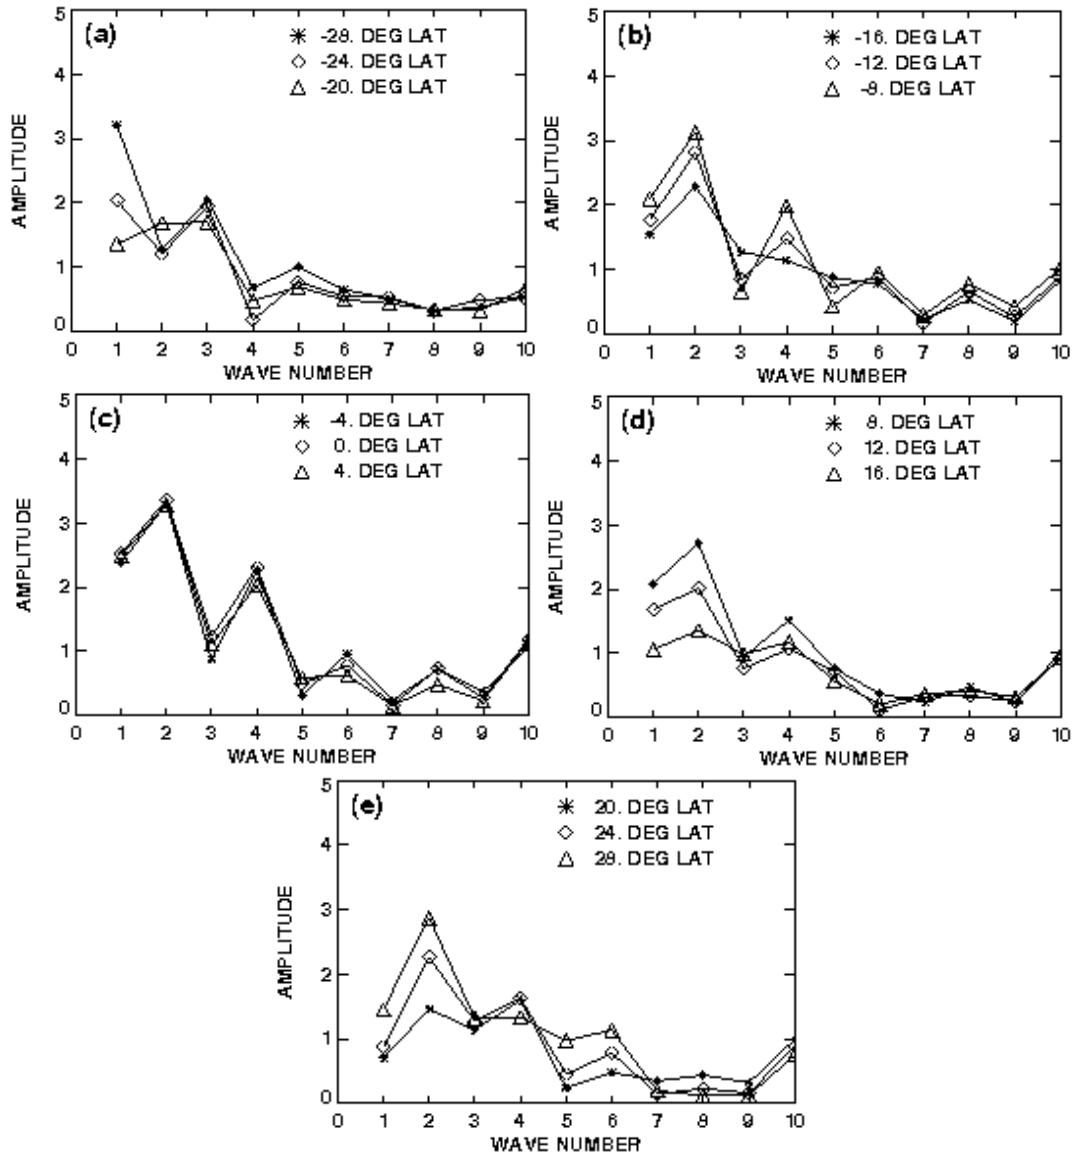
Fig. 3. Estimated Fourier amplitudes ( ◦ K) versus wave number based on zonal mean MLS temperature data at 0.46hPa (about 55km). Wave numbers 3, 4, 5 correspond to periods of 4, 3, 2.4 months, Figure 3. Estimated Fourier amplitudes (ºK) versus wave number based on zonal mean MLS Figure 3. Estimated Fourier amplitudes (ºK) versus wave number based on zonal mean MLS Figure 3. Estimated Fourier amplitudes (ºK) versus wave number based on zonal mean MLS temperature data at 0.46 hPa (about 55 km). Wave numbers 3, 4, 5 correspond to periods of 4, 3, Figure 3. Estimated Fourier amplitudes (ºK) versus wave number based on zonal mean MLS temperature data at 0.46 hPa (about 55 km). Wave numbers 3, 4, 5 correspond to periods of 4, 3, temperature data at 0.46 hPa (about 55 km). Wave numbers 3, 4, 5 correspond to periods of 4, 3, Figure 3. Estimated Fourier amplitudes (ºK) versus wave number based on zonal mean MLS 2.4 months, respectively. temperature data at 0.46 hPa (about 55 km). Wave numbers 3, 4, 5 correspond to periods of 4, 3, 2.4 months, respectively. 2.4 months, respectively. temperature data at 0.46 hPa (about 55 km). Wave numbers 3, 4, 5 correspond to periods of 4, 3, 2.4 months, respectively. 2.4 months, respectively.